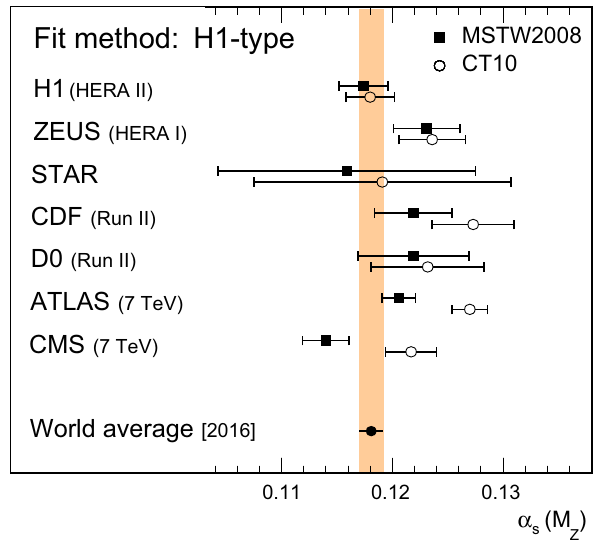
Fig. 2 Comparison of the α s ( M Z ) results with their experimental uncertainties obtained using the H1-type extraction methods for CT10 and MSTW2008 PDFs. The world average value [1] is shown together with a band representing its uncertainty